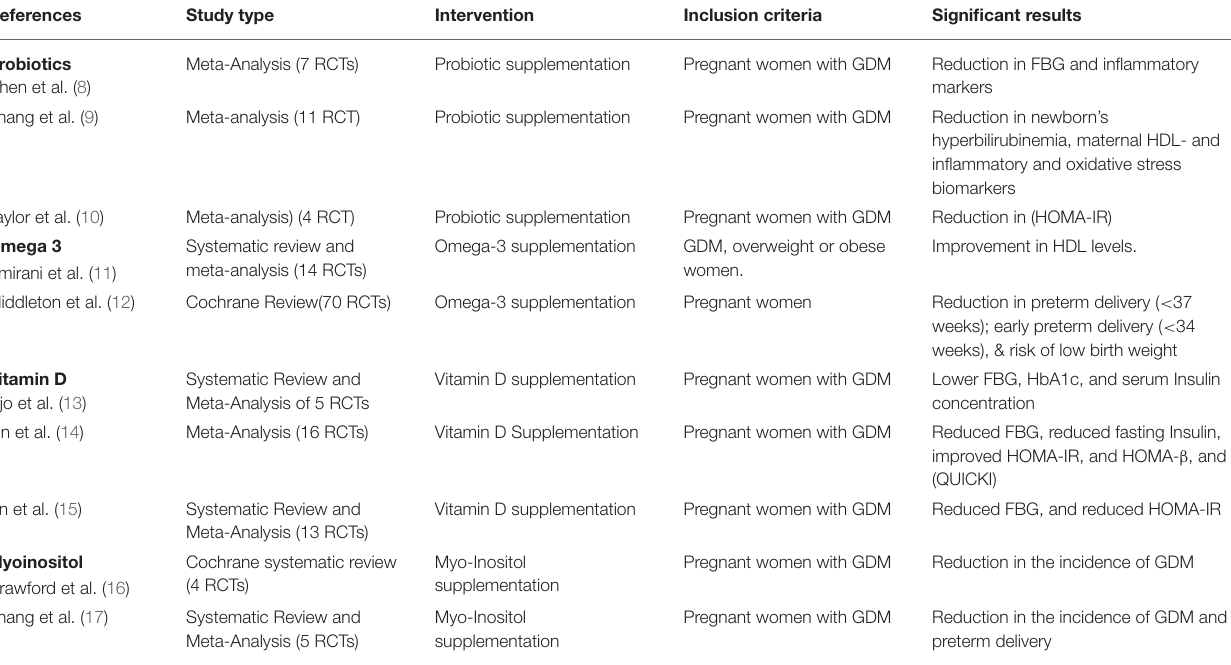
TABLE 1 | Summary of systematic reviews and meta-analyses of RCTs on the effects of nutritional supplementation during